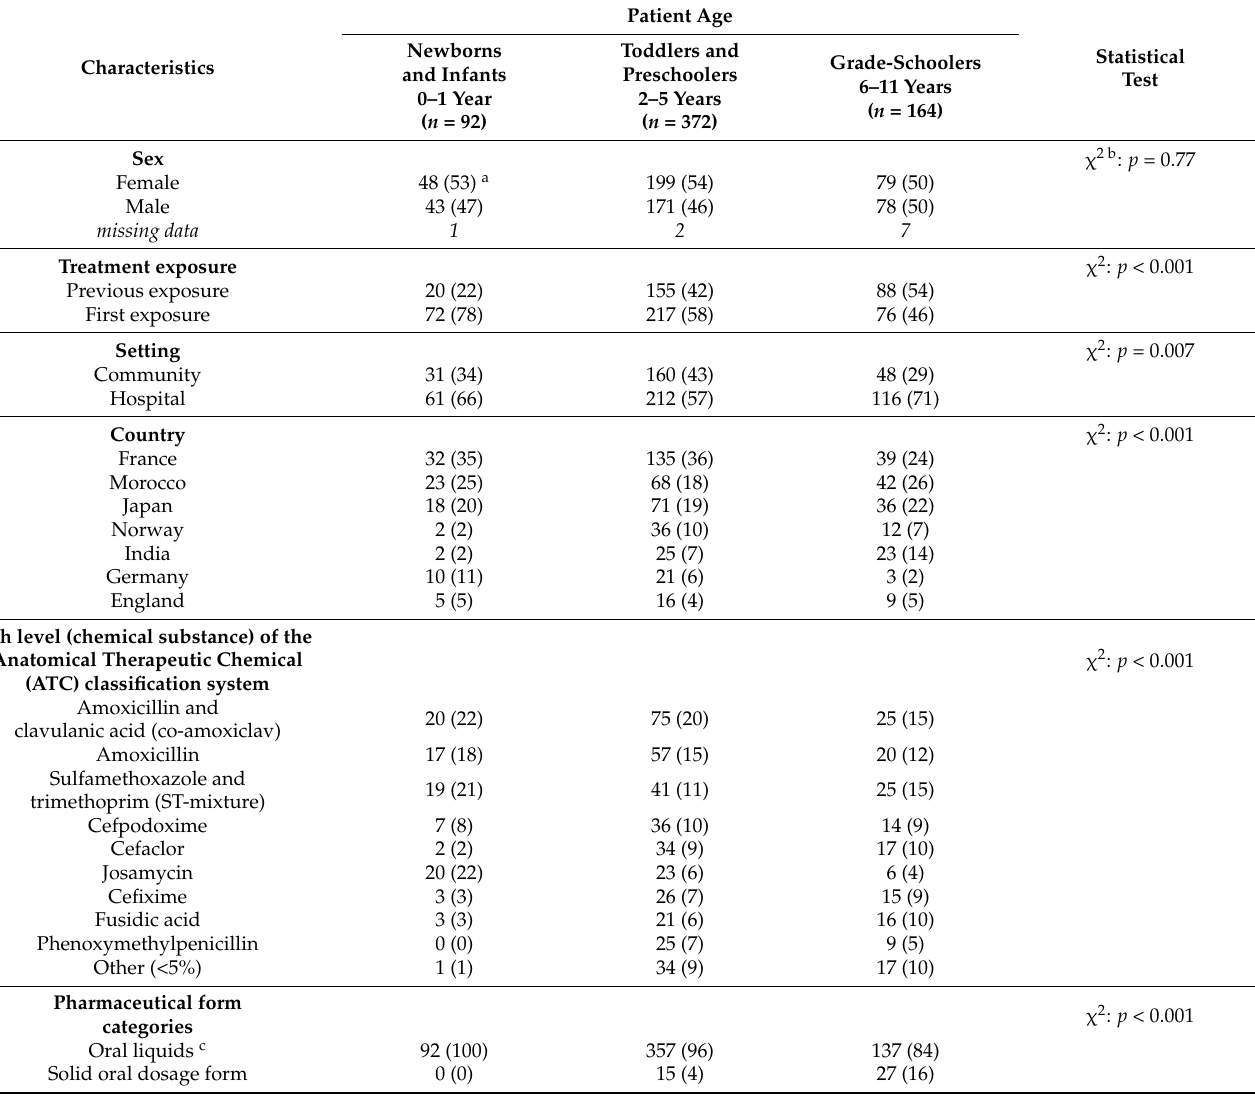
Table 1. Characteristics of the patients and products included in the study, stratified by patient age.